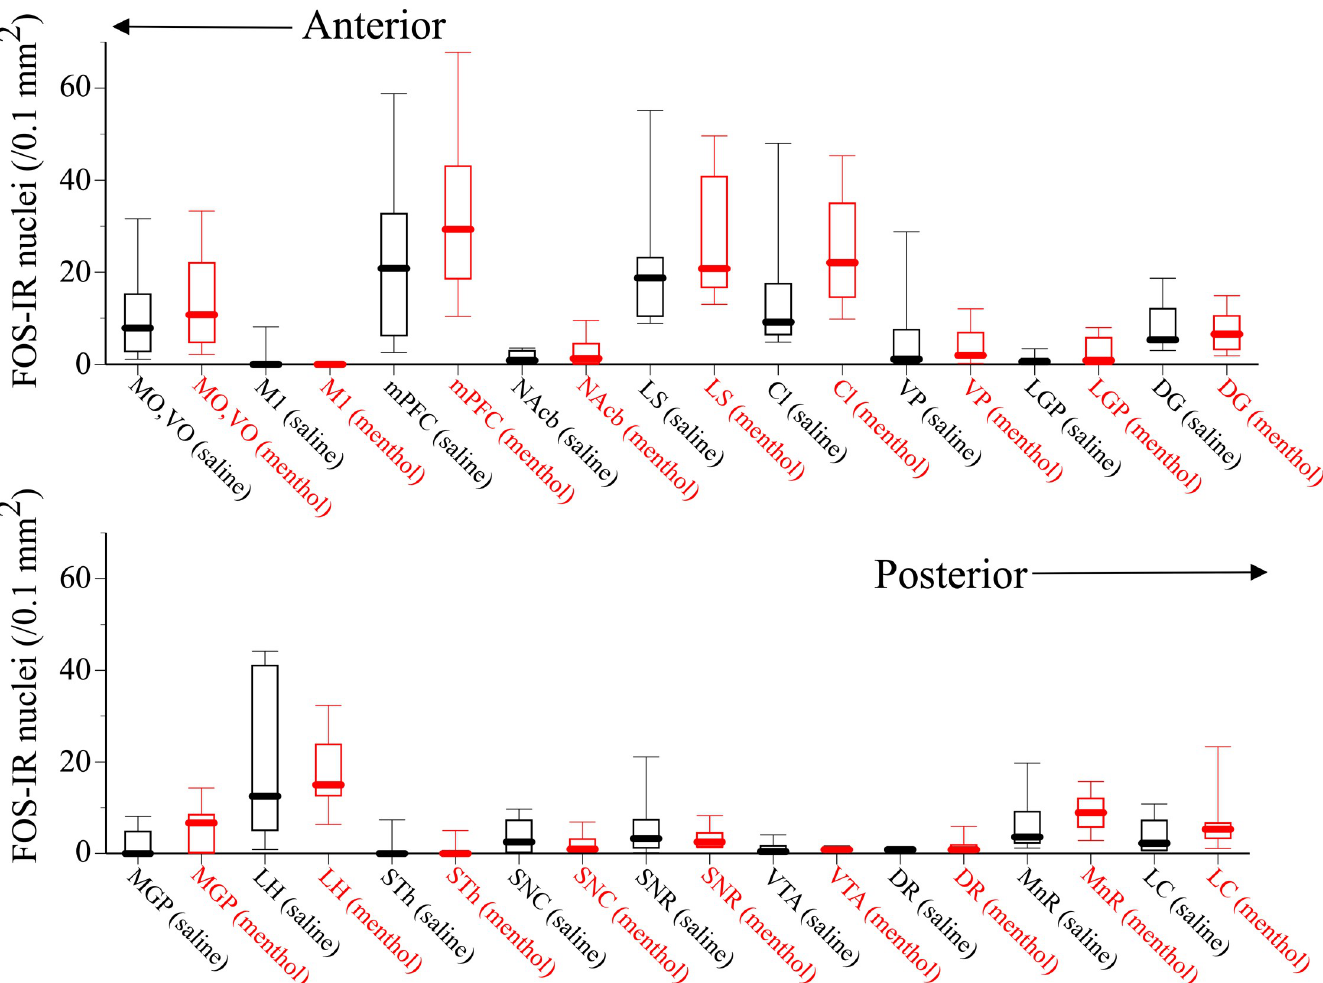
respectively; M1: primary motor cortex; mPFC: medial prefrontal cortex; LS: lateral septum nucleus; Cl: claustrum; NAcb: nucleus accumbens (including both the core and shell); VP: ventral pallidum; LGP: lateral globus pallidus; DG: dentate gyrus; MGP: medial globus pallidus; LH: lateral hypothalamus; STh: subthalamic nucleus; VTA: ventral tegmental area; SNC: substantia nigra, pars compacta; SNR: substantia nigra, pars reticulate; DR: dorsal raphe nucleus; MnR: median raphe nucleus; LC: locus